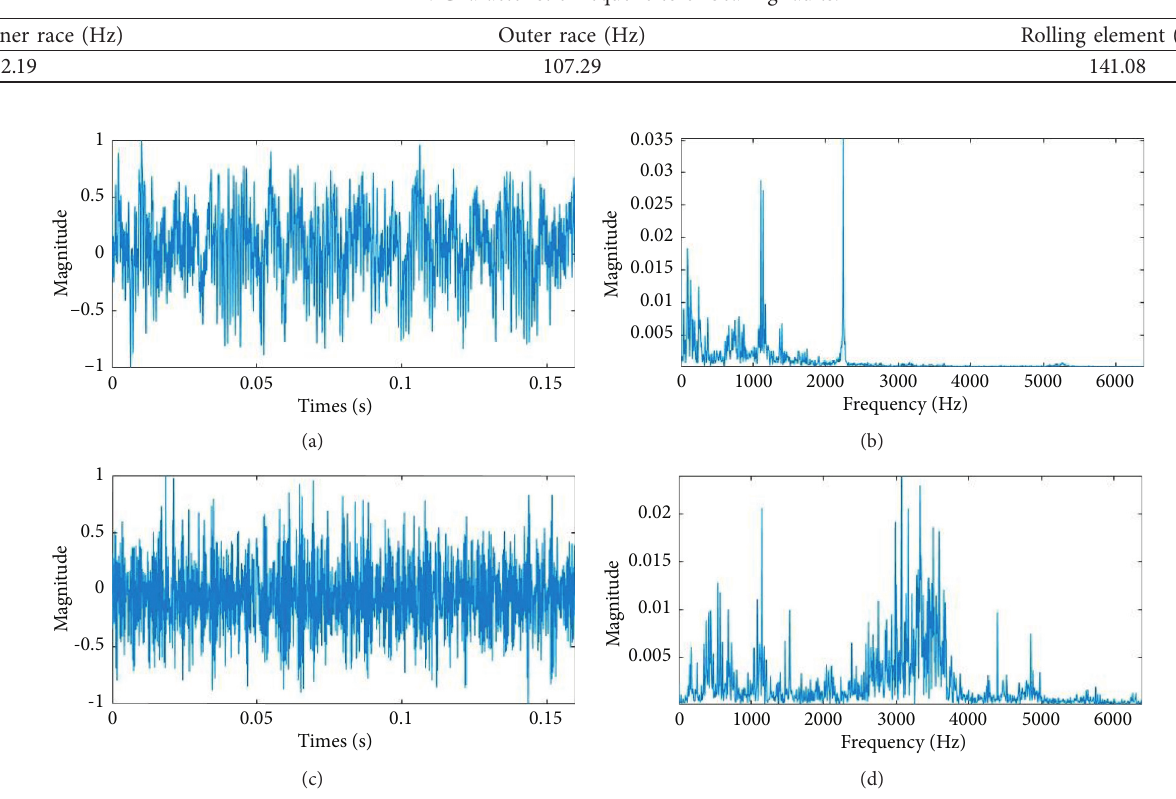
Figure 3: (a) Signal in the time domain of the motor in good condition. (b) Frequency spectrum of the motor in good condition. (c) Signal in the time domain of the faulty motor. (d) Frequency spectrum of the faulty motor.